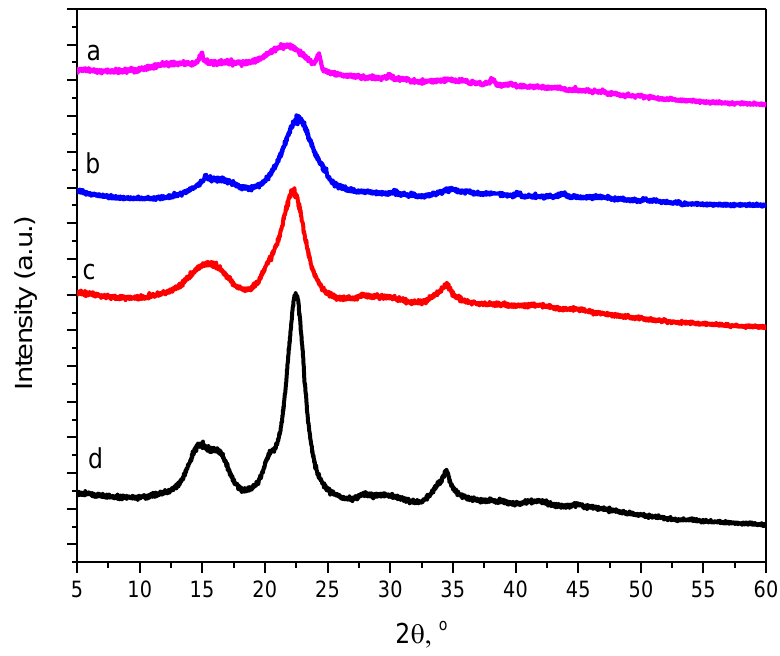
Figure 3. XRD of ( a ) untreated CP, ( b ) CNF procedure I, ( c ) CNF procedure II, and ( d ) MCC.